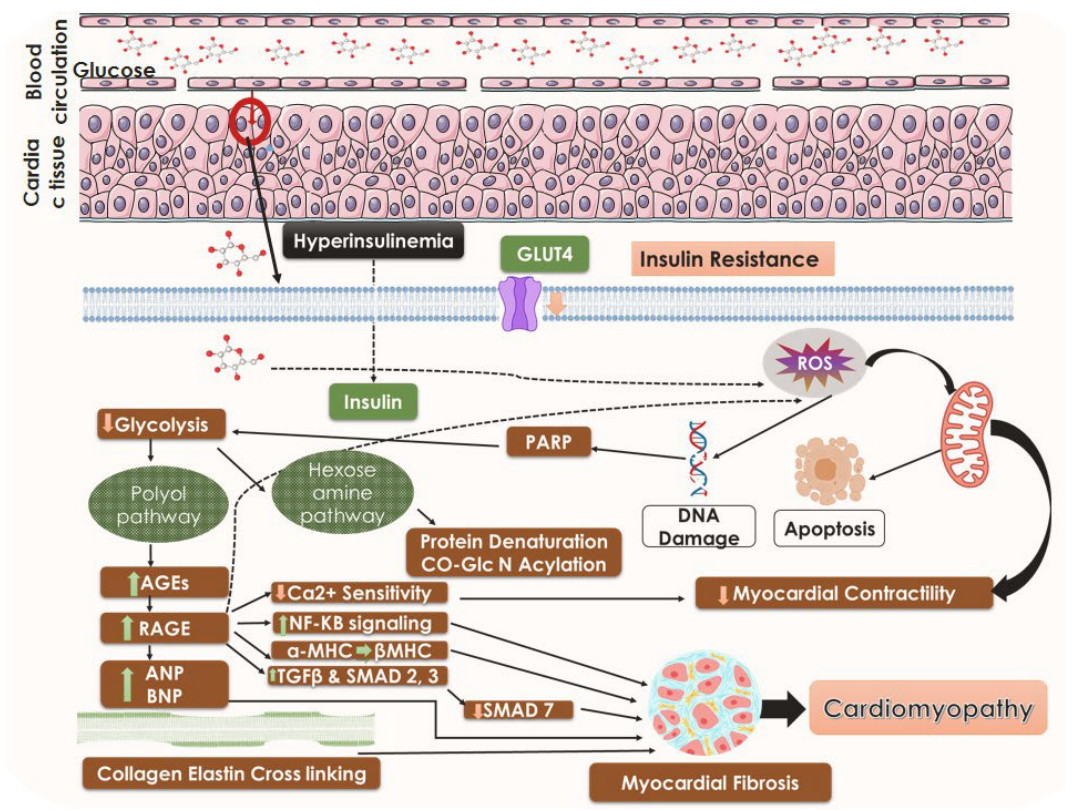
Figure 1. A general mechanistic understanding of DCM. Black arrows represent downstream events, black dotted arrows also represent downstream events however several steps are involved, the arrows pointing upward represent upregulation, and the arrows pointing downward represent suppression. GLUT 4, glucose transporter; AGEs, advanced glycation end products; RAGE, receptor for advanced glycation end products; ANP, atrial natriuretic peptide; BNP, brain natriuretic peptide; TGF β , transforming growth factor- β ; SMAD, suppressor of mothers against decapentaplegic; MHC, myosin heavy